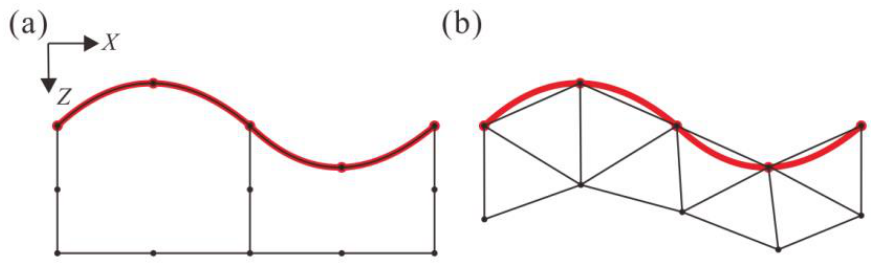
Figure 3. Schematic diagram of terrain simulation from a two-dimensional perspective. ( a ) Using curved hexahedrons; ( b ) using